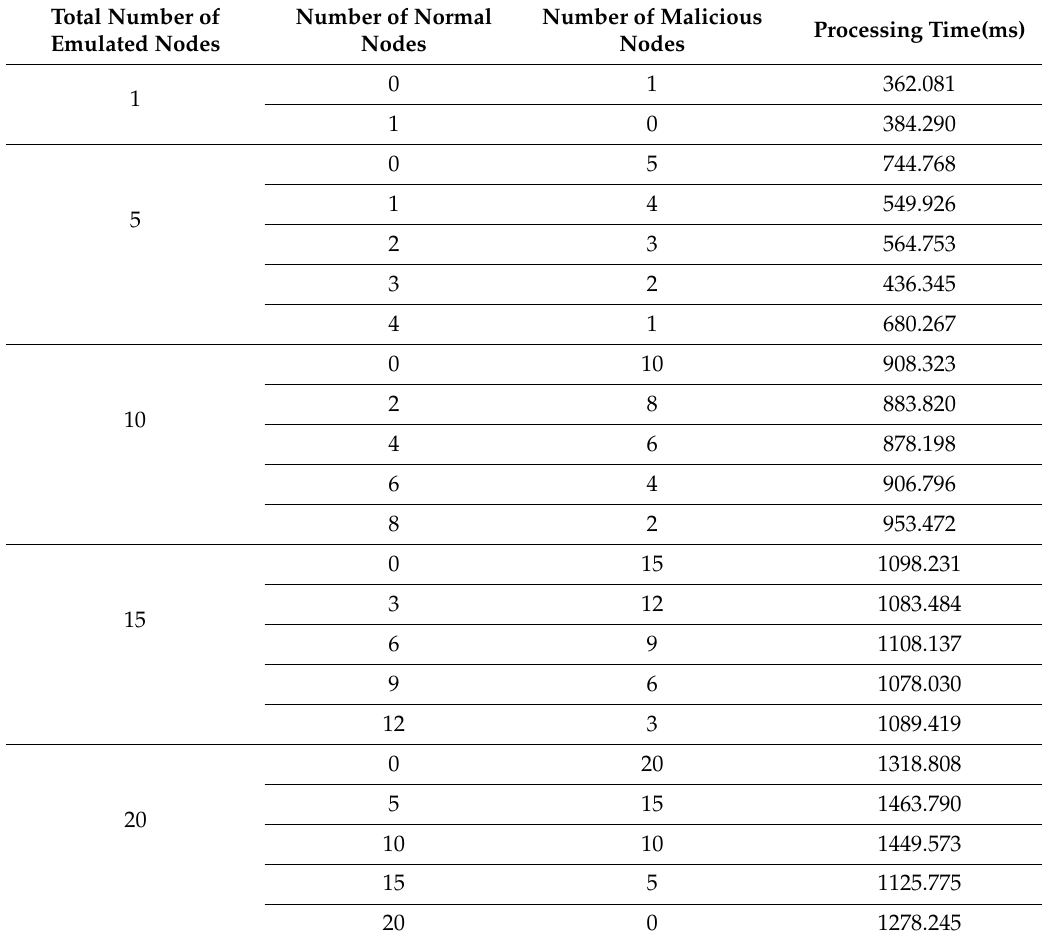
Table 1. Processing time with di ff erent numbers of